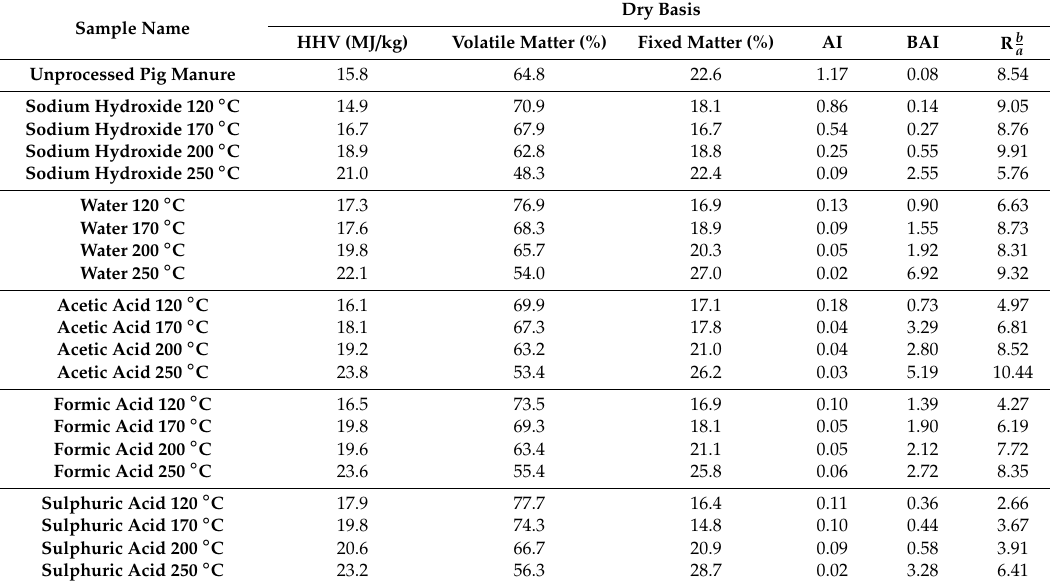
Table 5. Energy content, volatile content, and slagging and fouling indices for the bio-coals. HHV—higher heating